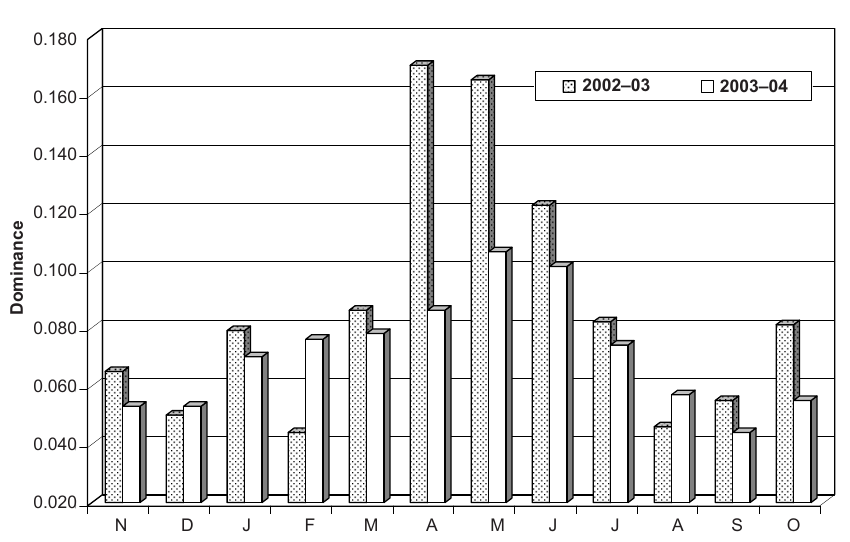
Figure 10. Monthly variations in dominance of zooplankton